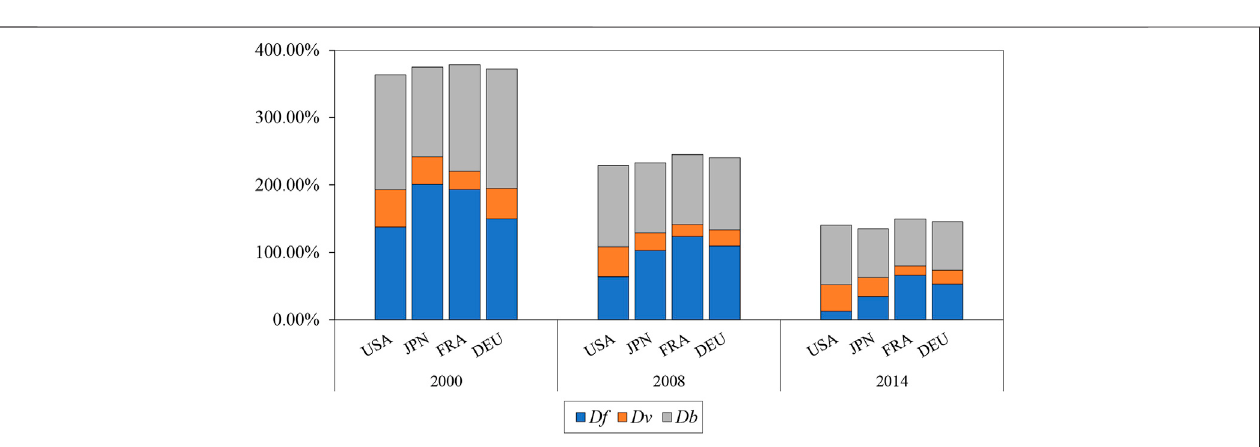
FIGURE 8 | SDA results of DCEI differences between China and selected countries in the years 2000, 2008, and 2014.